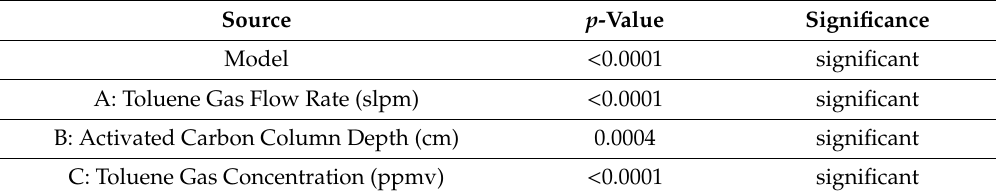
Table 6. Significance related details for the logarithmic linear toluene exhaustion RSM model.